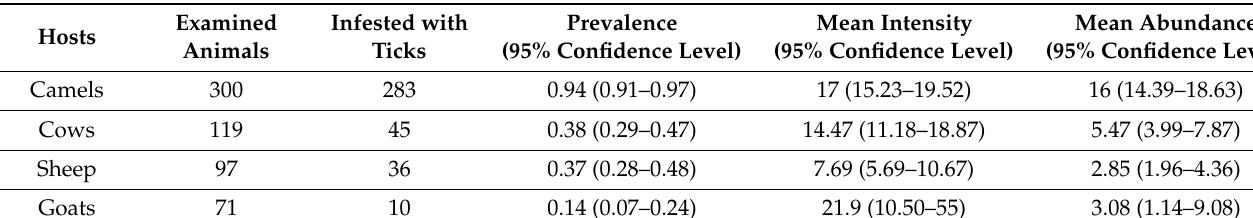
Table 3. Tick prevalence, mean intensity, mean abundance on camels, cows, sheep, and goats in the sampling areas, UAE.